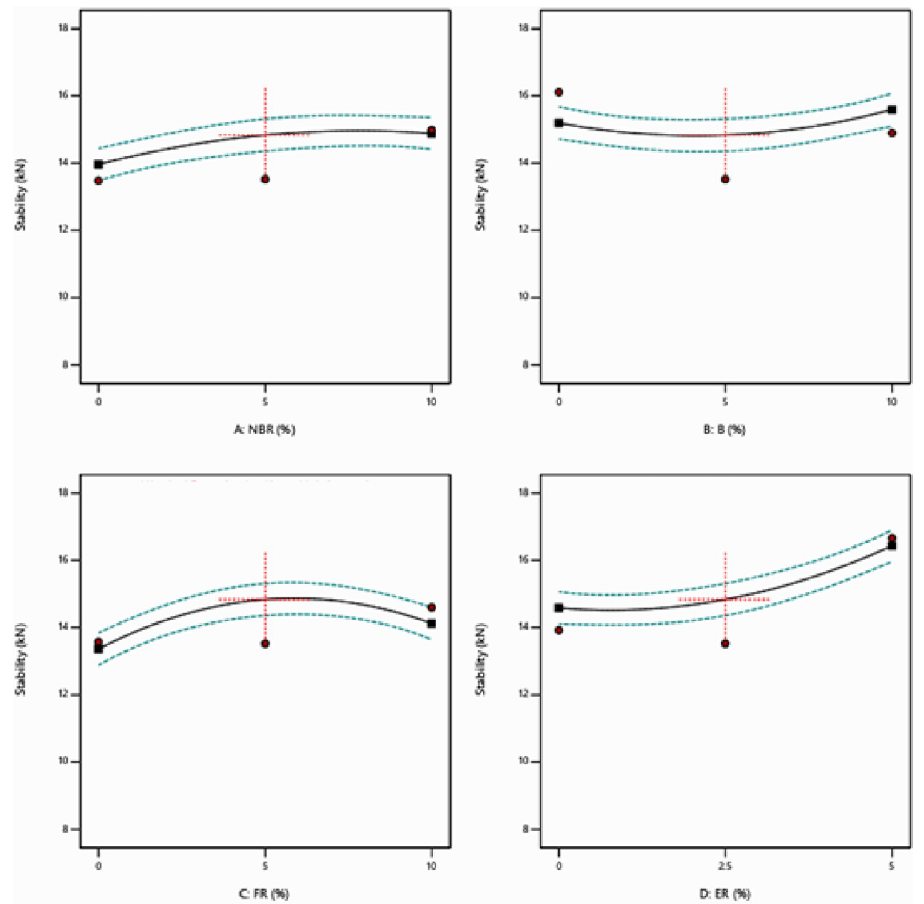
Fig 3. Individual effect plot for